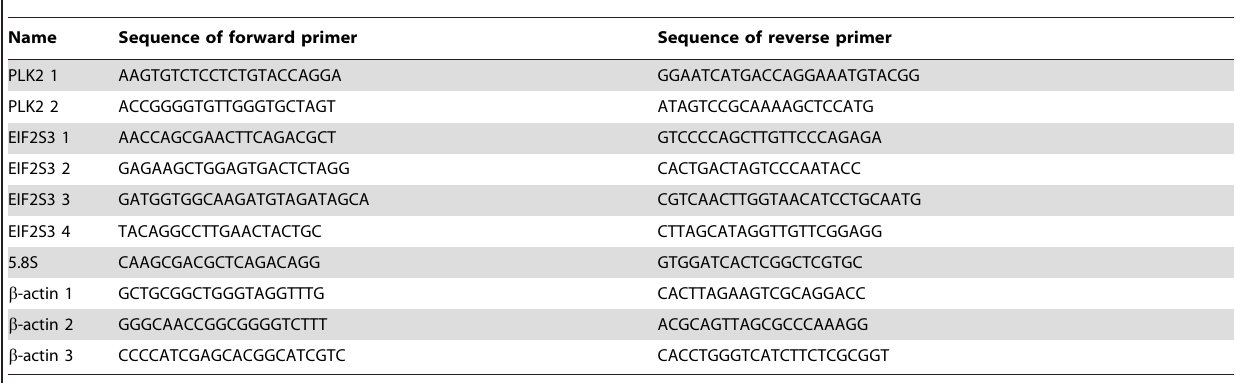
Table 1. Sequence of primer sets used for qRT-PCR